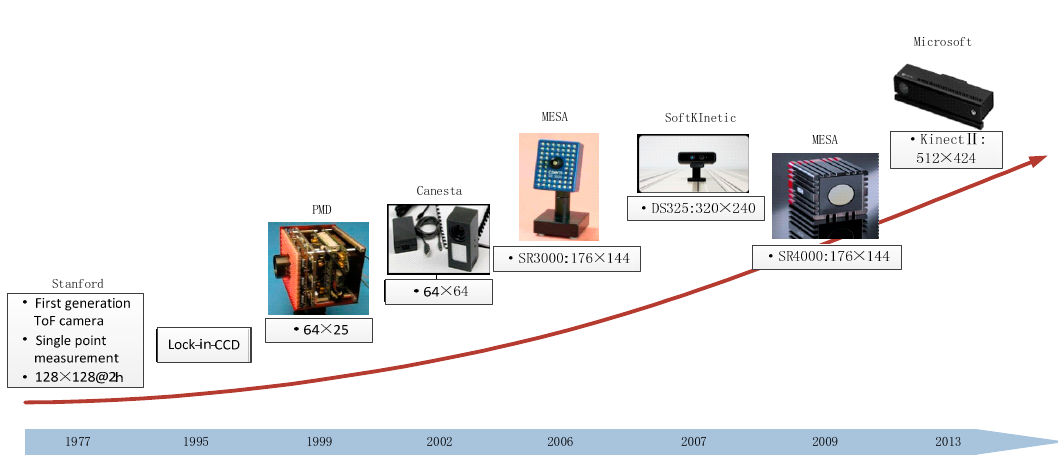
Figure 1. Development history of ToF cameras.